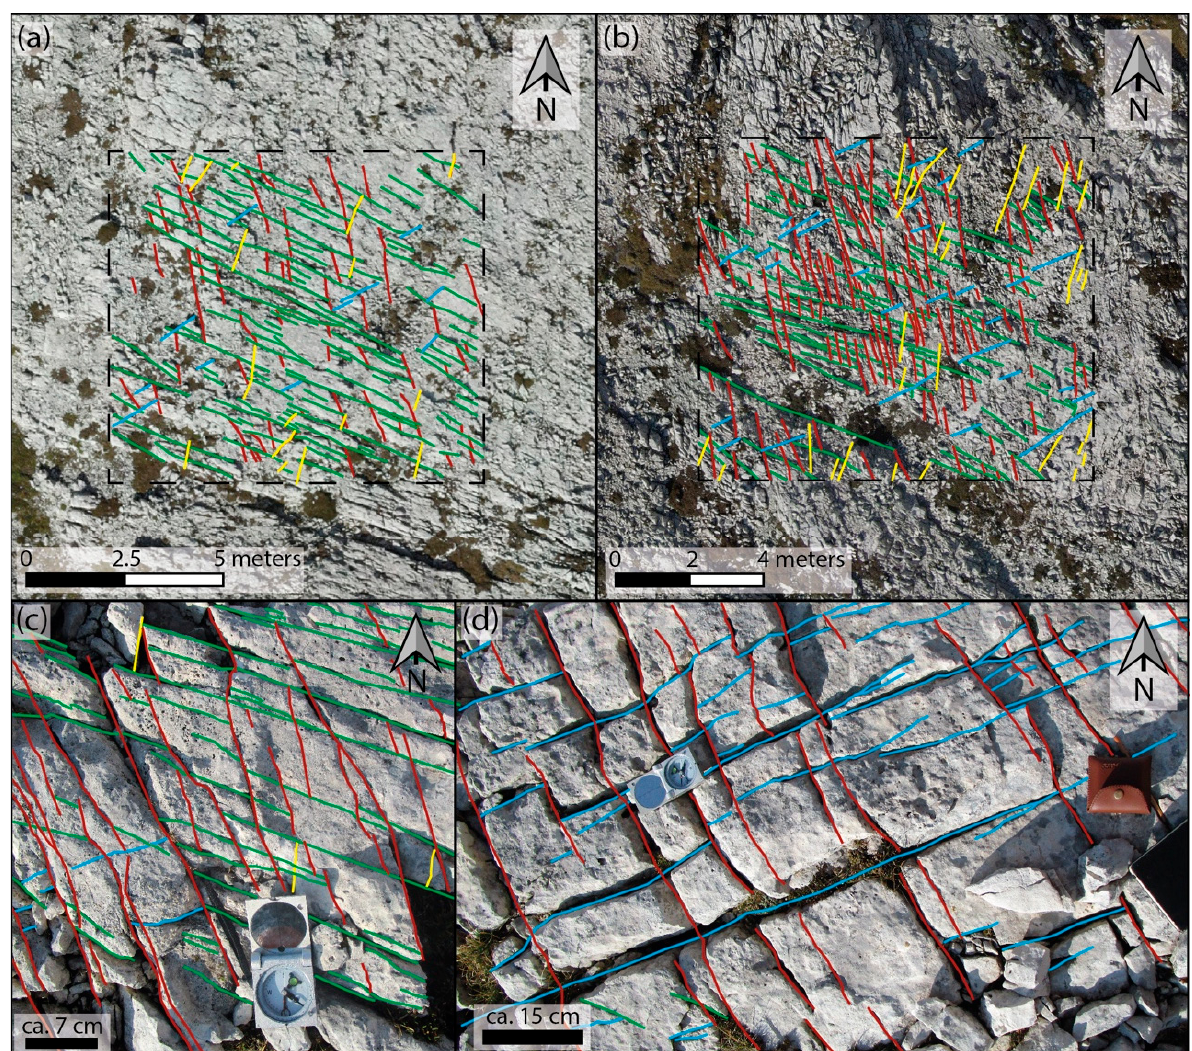
Figure 8. ( a , b ) Examples of scan-windows analysis performed using the highest-resolution (2 cm) DOM. ( c , d ) Examples of fractures mapped in the field during the rectangular-window scanning. K1, K2, K3, and K4 fractures are marked by green, red, yellow, and light blue traces, respectively.